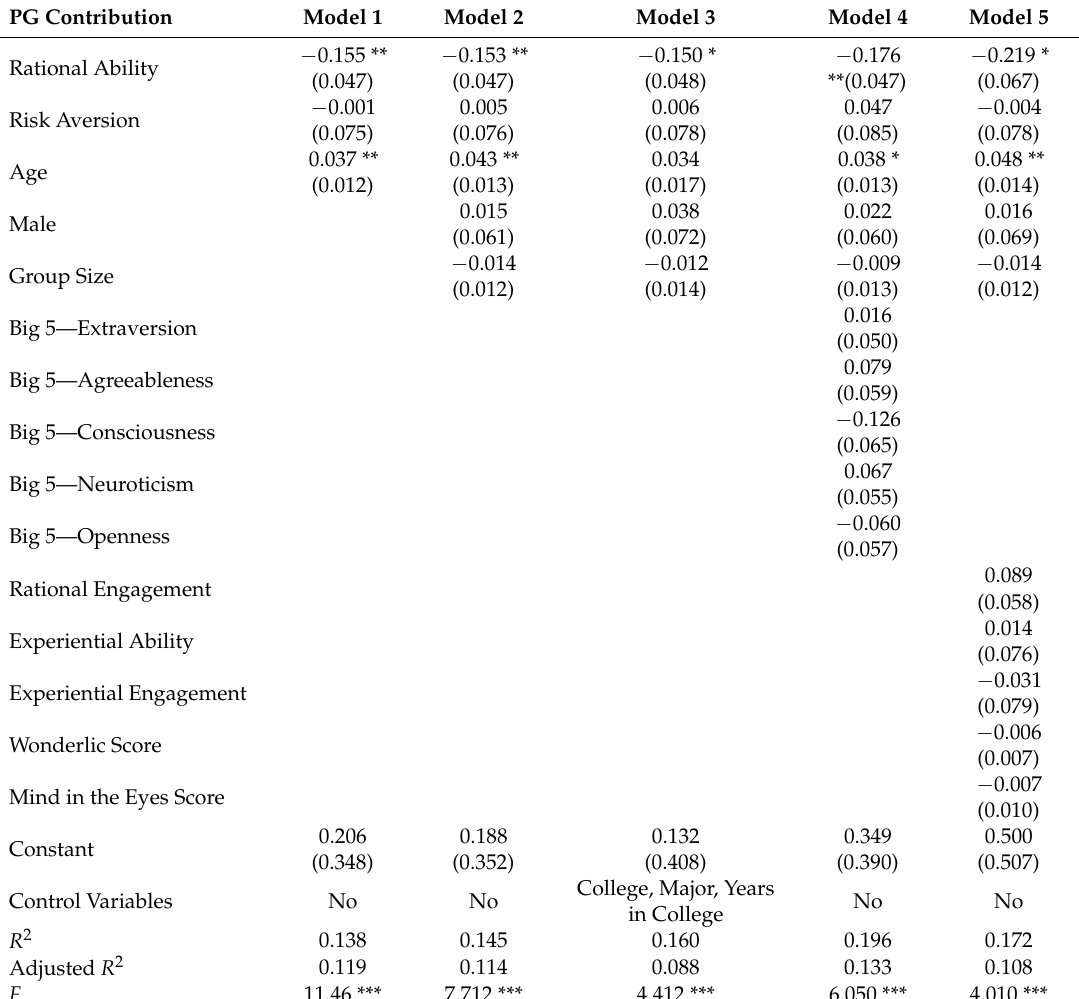
Table 3. Regression results: PG